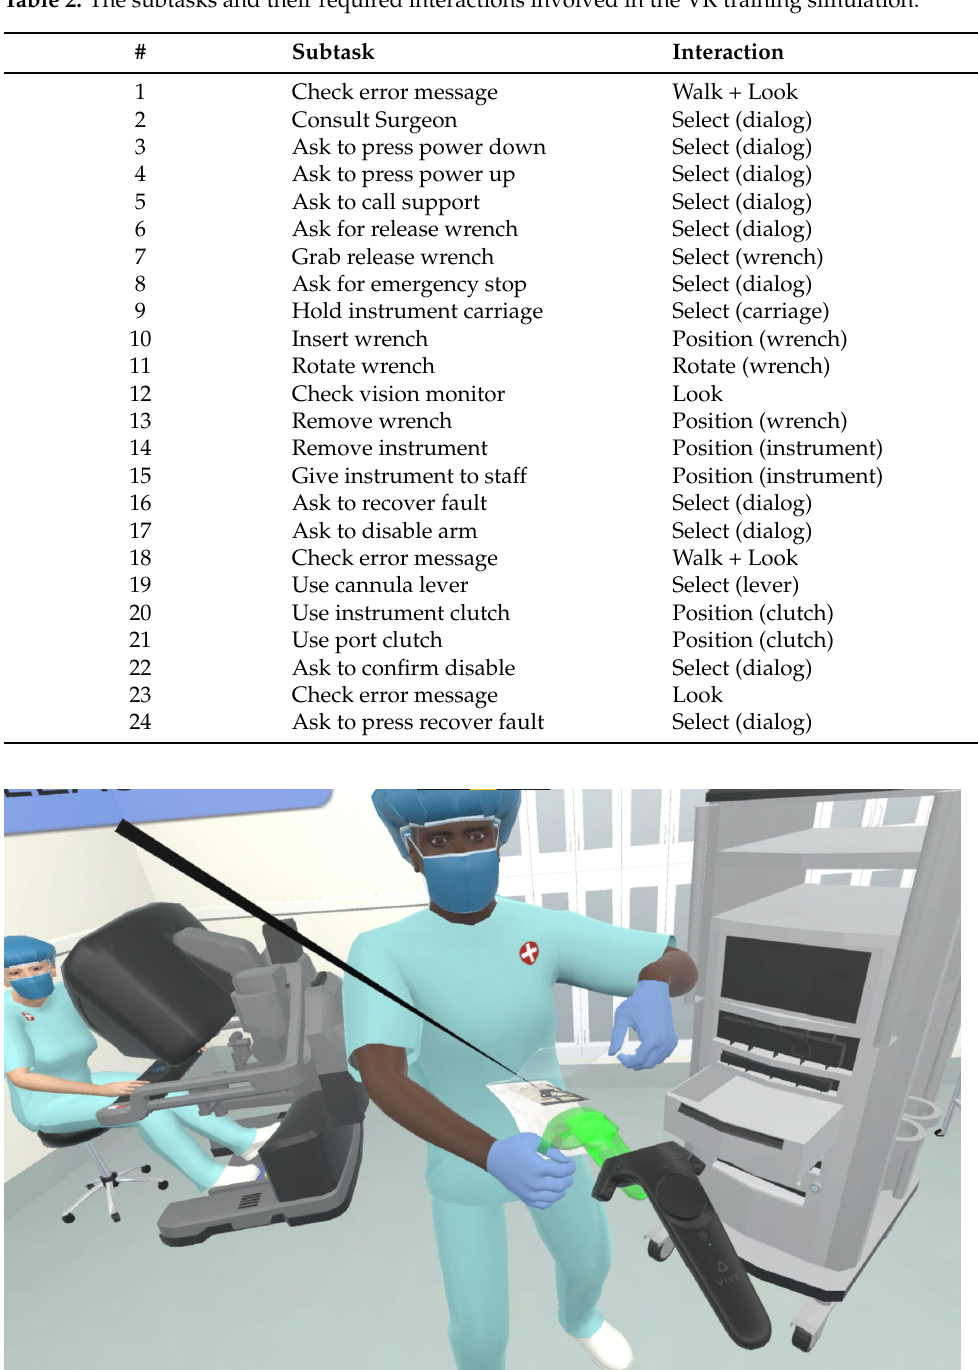
Table 2. The subtasks and their required interactions involved in the VR training simulation.